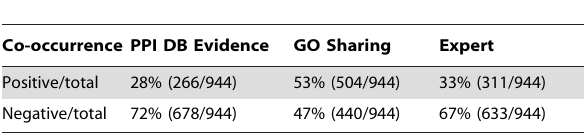
Table 3. Sensitivity Evaluation.